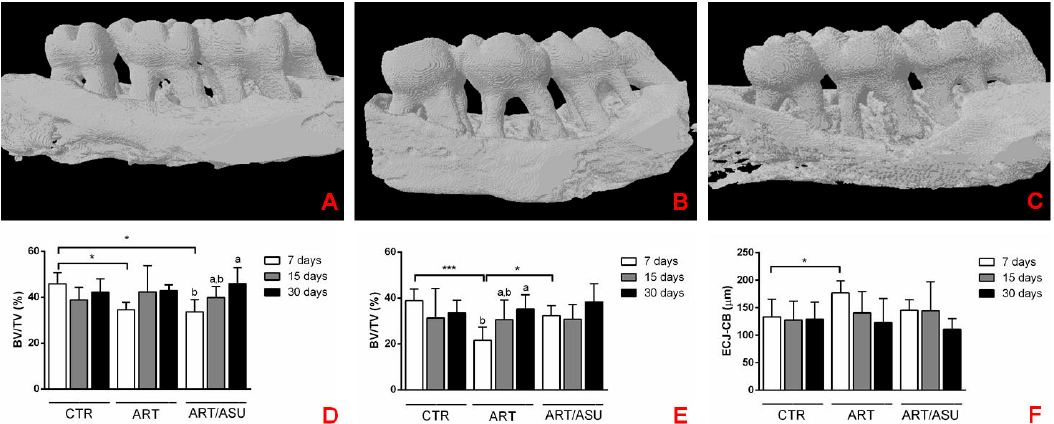
Figure 3- 3D-images from micro-CT scans representing all groups at the 7-day period, and the representative graphs of the analyses. A) CTR, B) ART, C) ART/ASU: It is possible to notice the greater degree of bone resorption in the ART group in relation to the other groups. The use of ASU reduced bone resorption in animals with induced arthritis; however, this effect was not enough to reach the same condition of the CTR group. D) BV/TV (%) of the inter-radicular region; E) BV/TV (%) of the interproximal regions; and F) the linear distance from